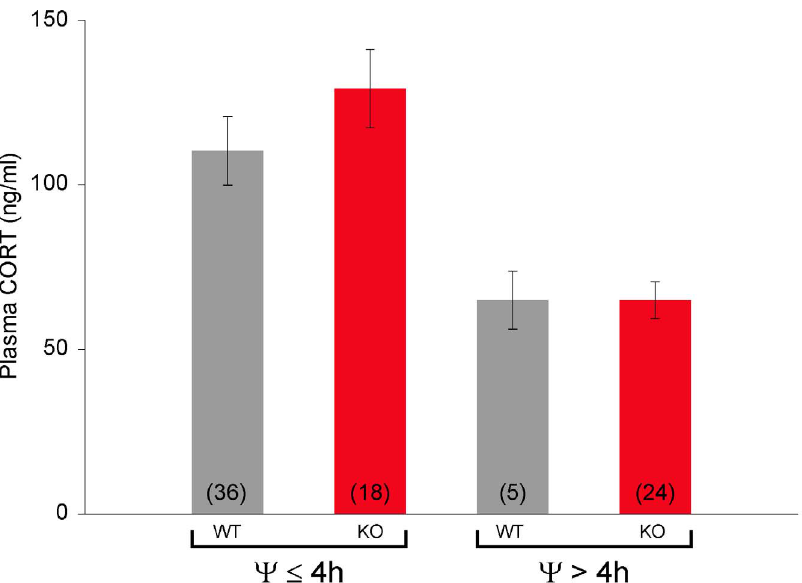
Figure 6. Peak plasma CORT levels are reduced in animals with delayed activity onsets in 9.5L:13.5D. Peak plasma CORT values for WT and KO animals entrained with activity onsets # 4 h or . 4 h after light offset. Peak plasma CORT values are dependent on Y (p , 0.0001) but not genotype (p . 0.05).